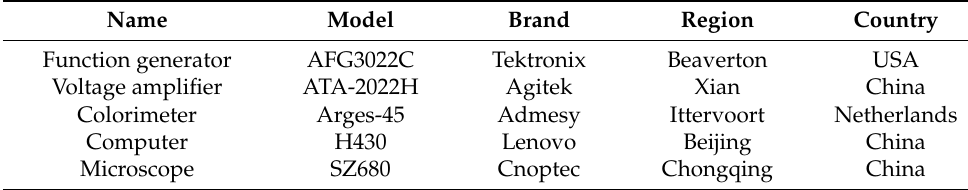
Table 1. Parameters of experimental instruments.